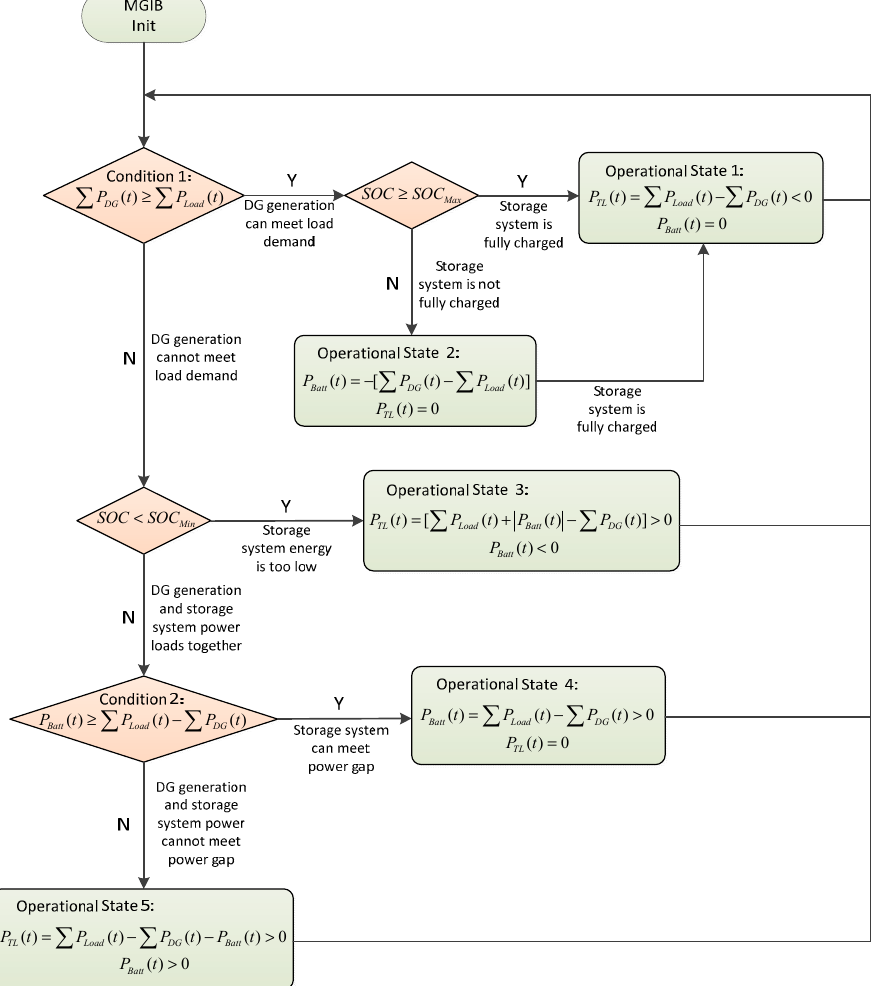
Figure 6. Power consensus control strategy of Microgrid-Enabled Intelligent Building.